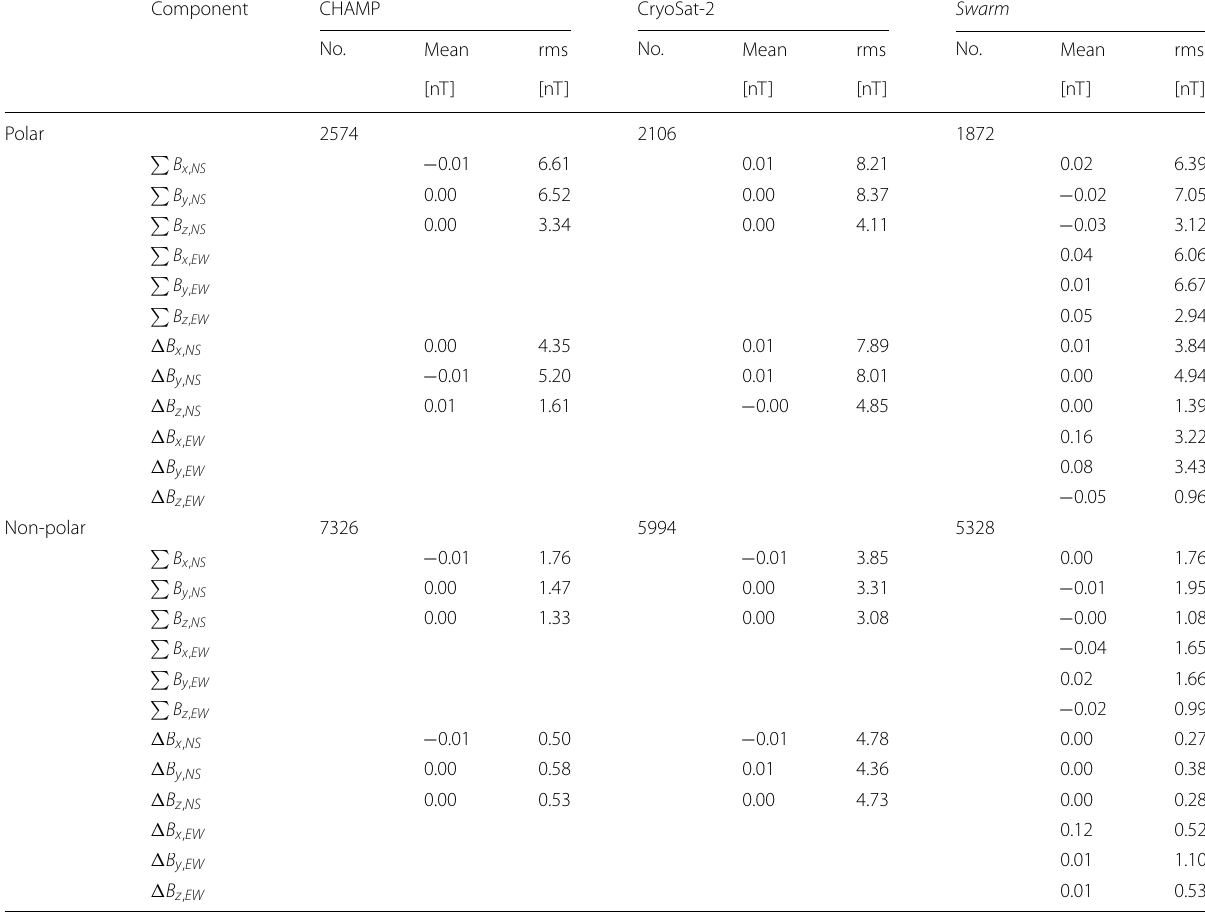
Table 2 GVO model rms misfit statistics between GVO estimates and the contributing data for the global grid of 300 GVOs during CHAMP, CryoSat-2 and Swarm . Here (cid:31) and (cid:31) represent data sums and data differences, respectively, split into the North-South (NS) and East–West (EW)